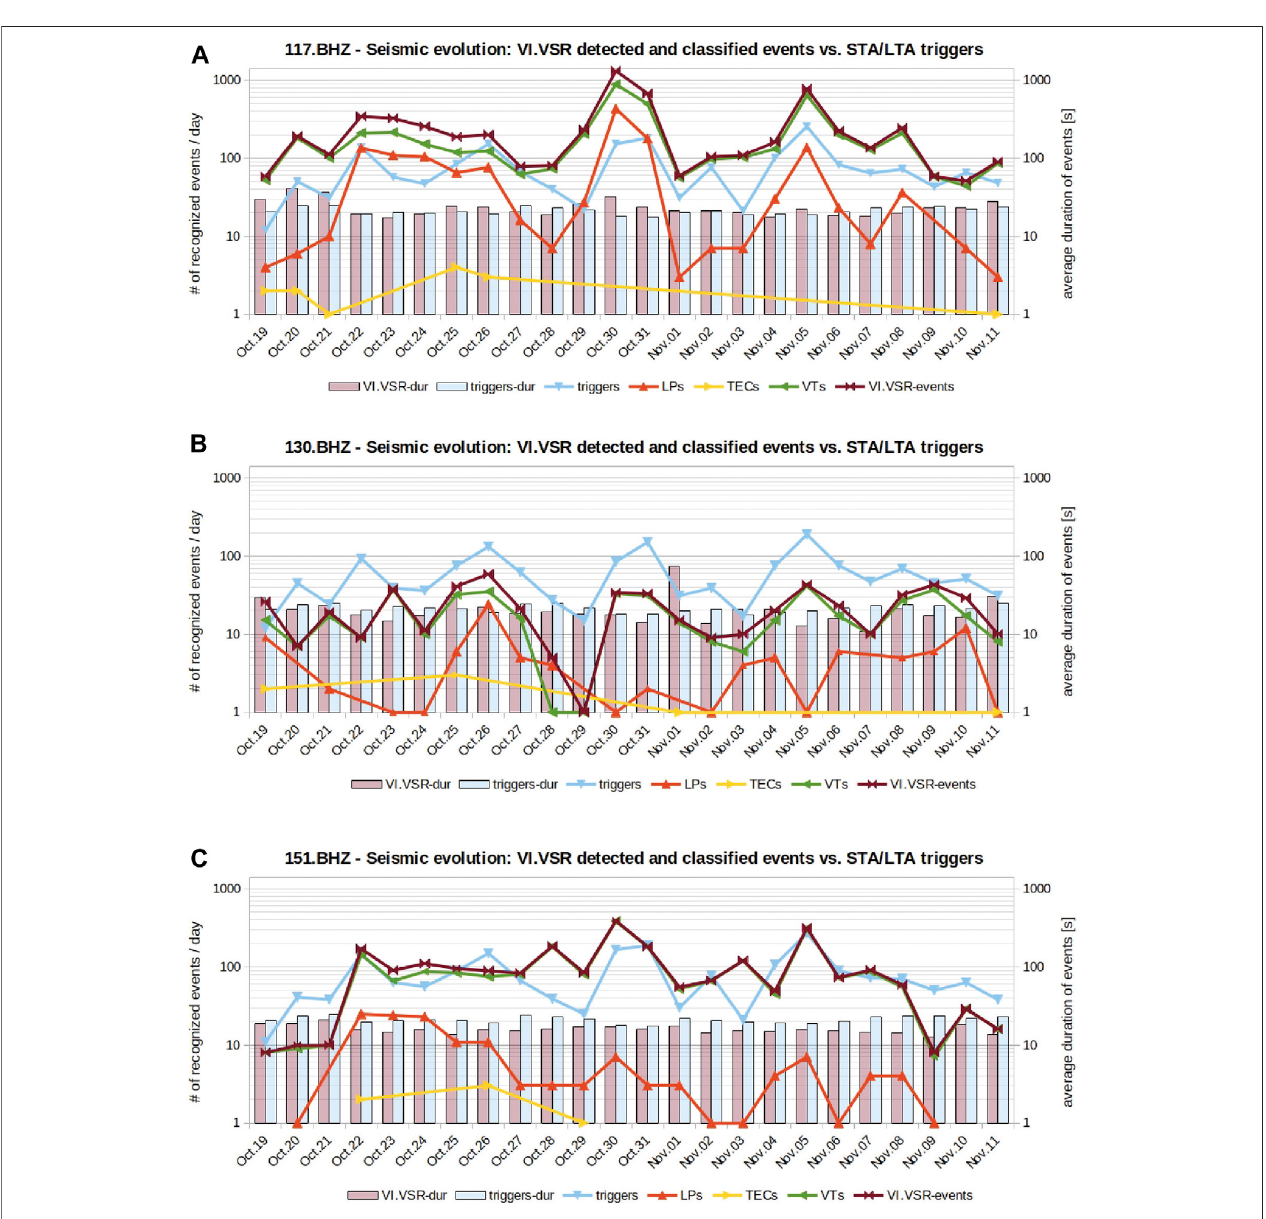
FIGURE5| Seismic evolution fornodes 117 (top) ,130 (middle) , 151 (bottom) (see Figure 1 for locations). Plot ofthe type and duration ofevents (long periods – LPs, tectonics – TECs and volcano-tectonic – VTs earthquakes) automatically recognized by the Volcano-Independent Seismic Recognition (VI.VSR) system. For comparison the number and duration of the event triggers found by the classic STA/LTA algorithm are also shown. The VI.VSR classi fi ed and STA/LTA detected events show a similar pattern in all stations.